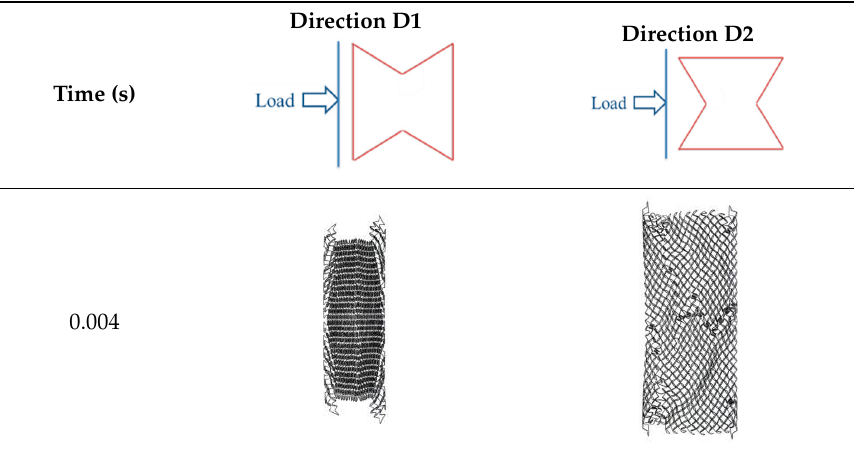
Table 4. Loading directions D1 and D2 and their effect on the collapse mode and deformation of an